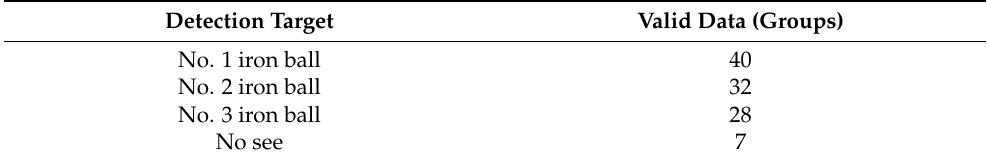
Table 5. Validation set contains label